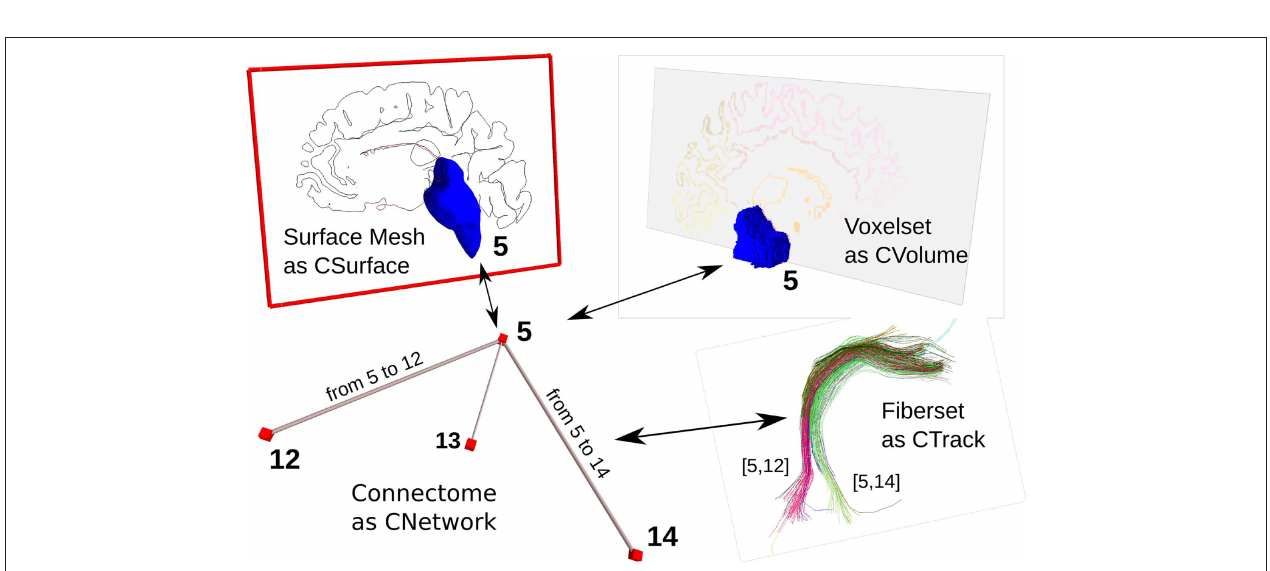
Figure 3 | Networks are represented using the graphML file format. The storage of an arbitrary number of attributes on the nodes and edges is possible. For instance, nodes denoting brain regions may link to semantic frameworks where definitions, delineation criteria, and literature references given. Standardized node positions are useful in graph layouting for comparison.